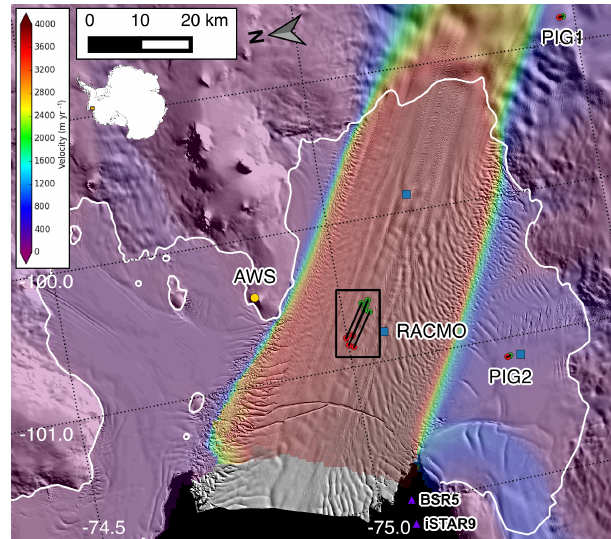
Figure 1. Context for Pine Island Glacier ice shelf with 2006–2016 median surface velocity (Christianson et al., 2016; Joughin et al., 2010) over a shaded relief map from October–December 2012 DEM mosaic. Black lines show ∼ 2-year paths between initial (green) and final (red) GPS station locations. The yellow dot shows the Evans Knoll automated weather station (AWS) and the blue squares show RACMO grid-cell centers used during analysis. The purple triangles beyond shelf front show locations of ocean mooring temperature data from Christianson et al. (2016). The white line shows approx- imate 2011 grounding line (Shean, 2016). Black rectangle shows location of Fig.